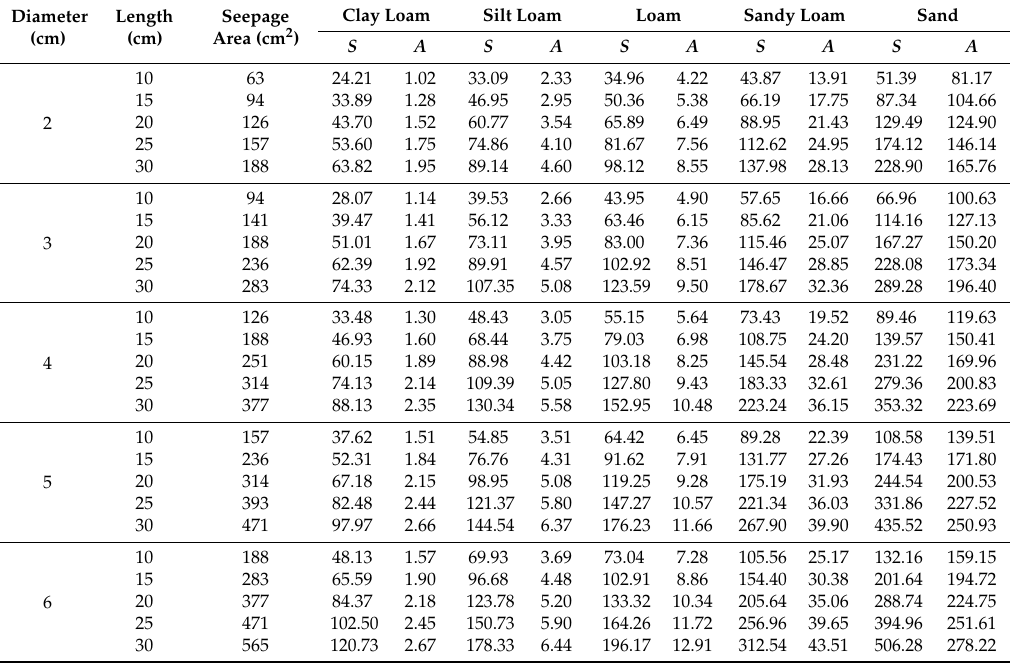
Table 1. Fitted infiltration parameter values.